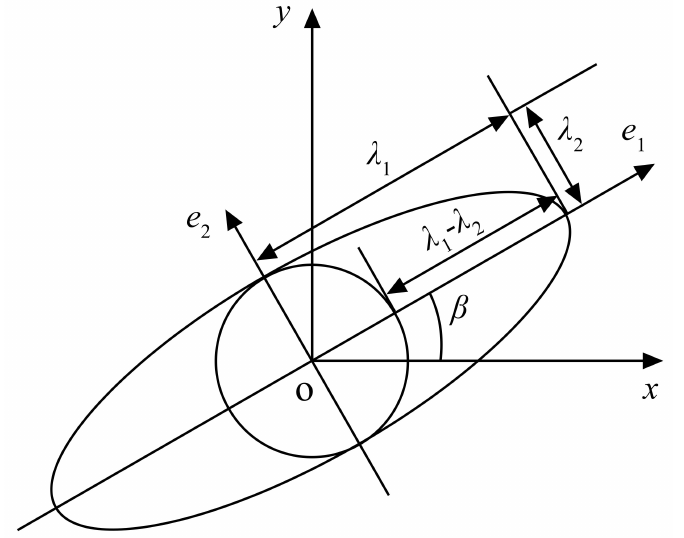
Figure 2. Geometric decomposition of tensor voting